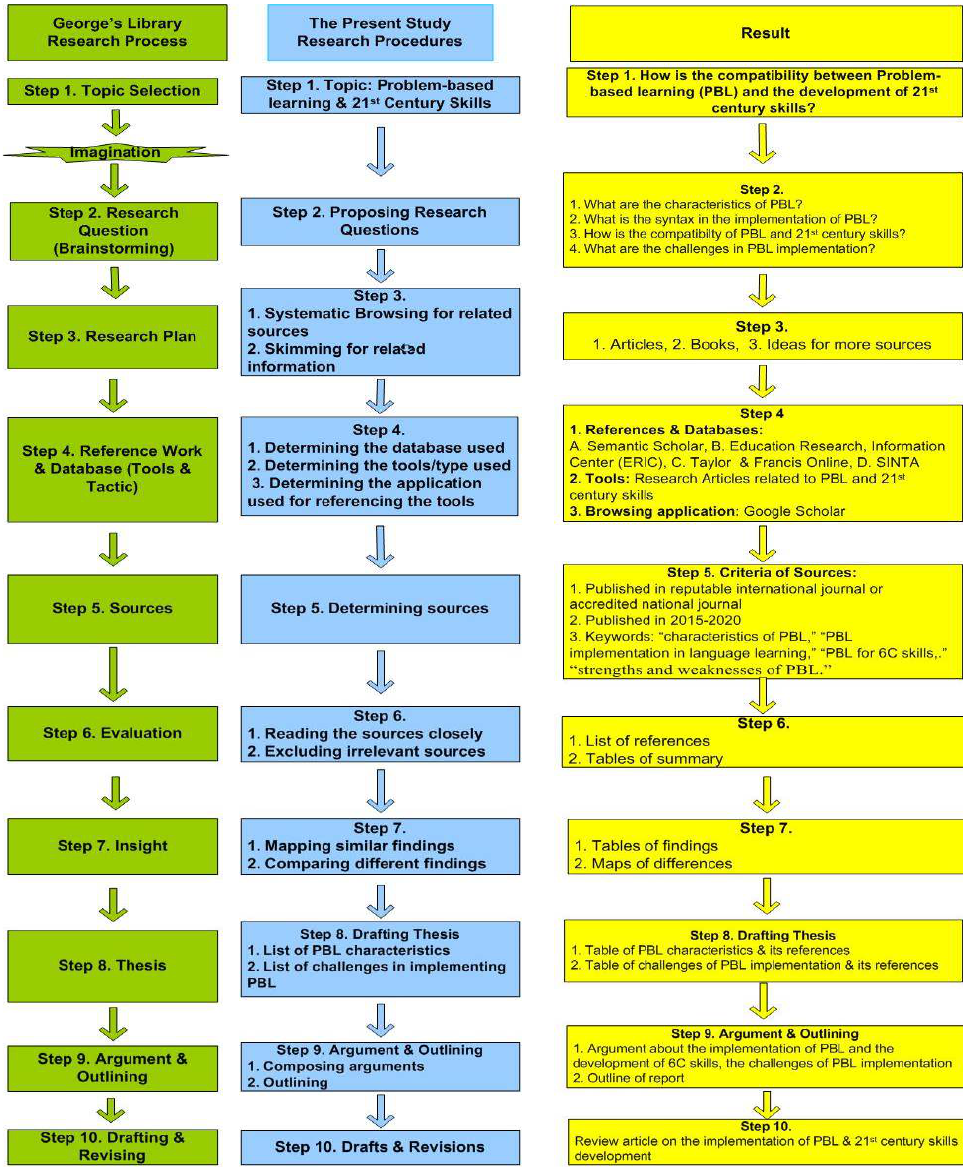
Figure 1. George’s library research